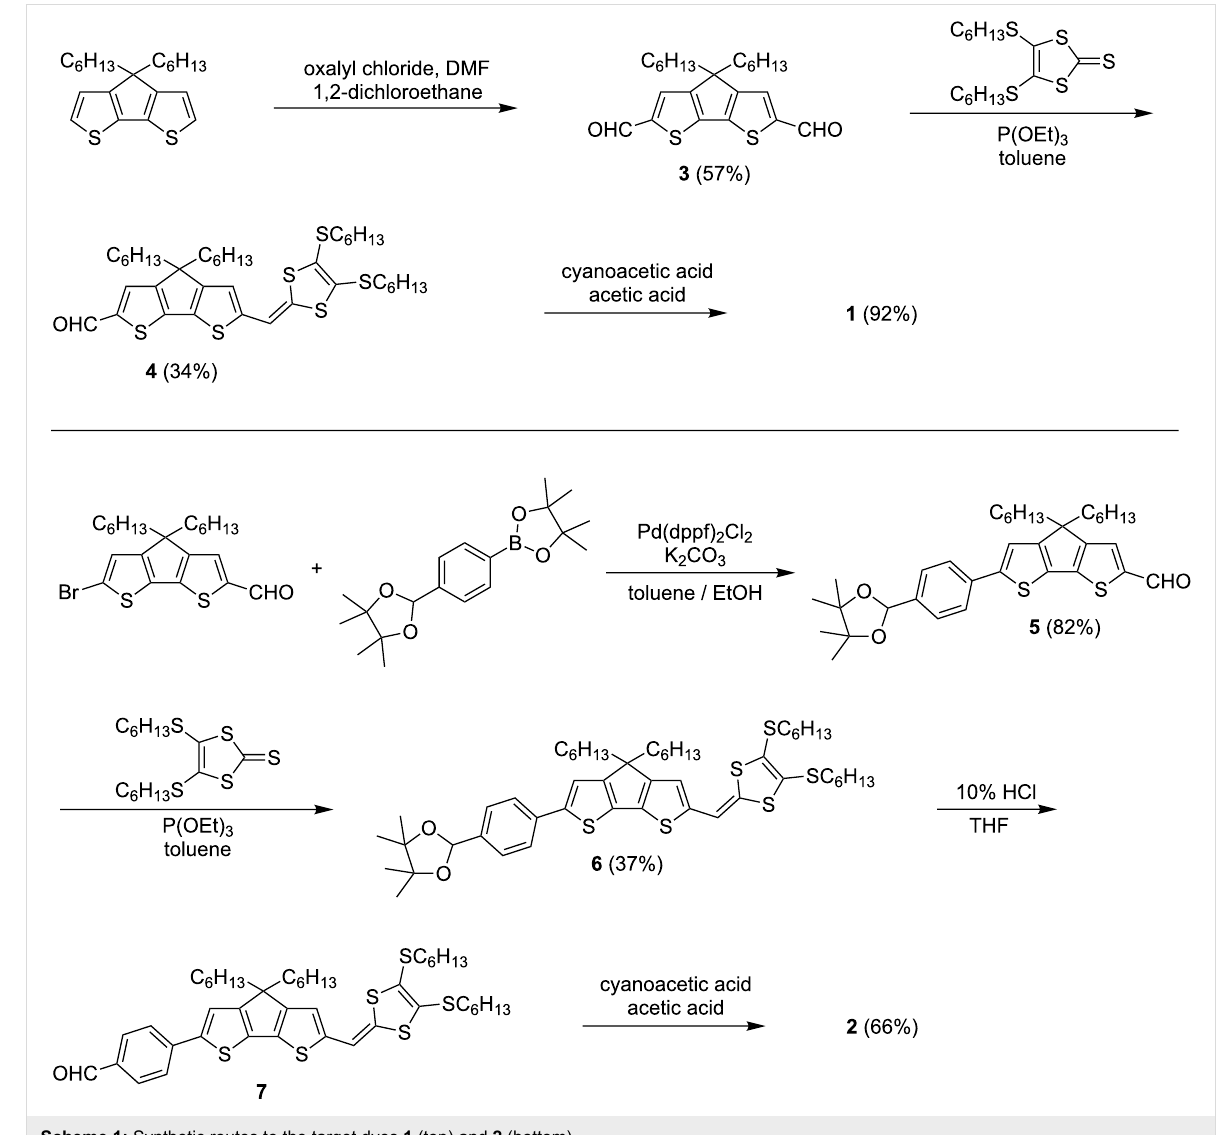
Scheme 1: Synthetic routes to the target dyes 1 (top) and 2